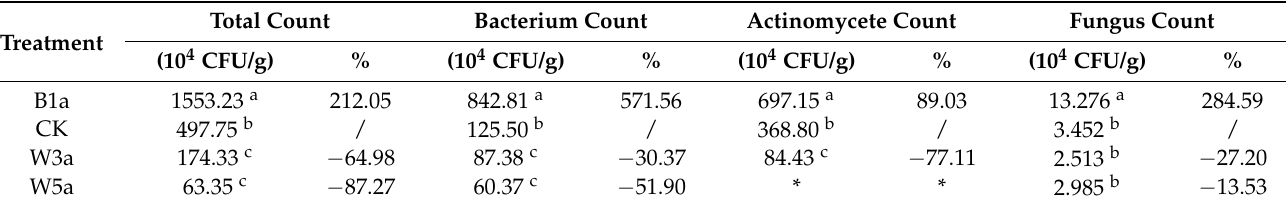
Table 3. The number of soil culturable